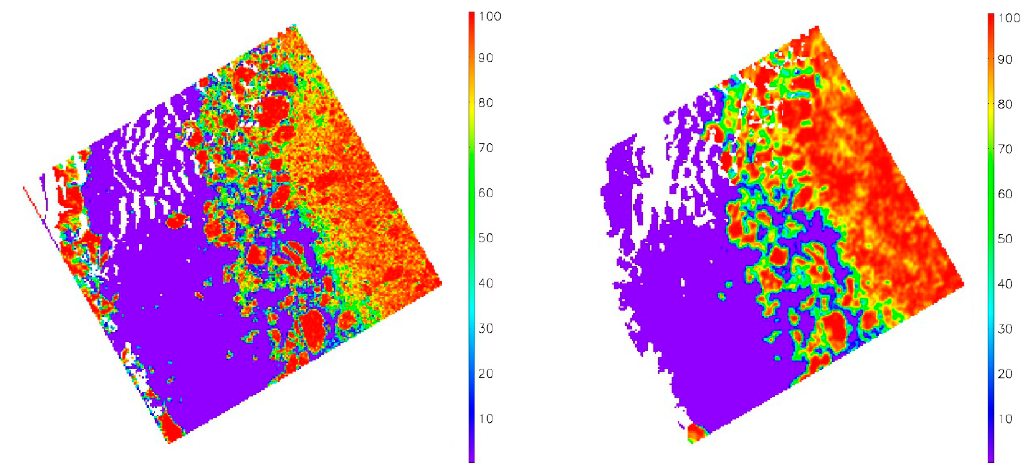
Figure 8. ( left ) Sea ice concentration derived from the Landsat image in Figure 2; and ( right ) the calculated sea ice concentration using the Suomi NPP VIIRS data in Figure 2. White areas denote pixels flagged out as either land or cloudy.